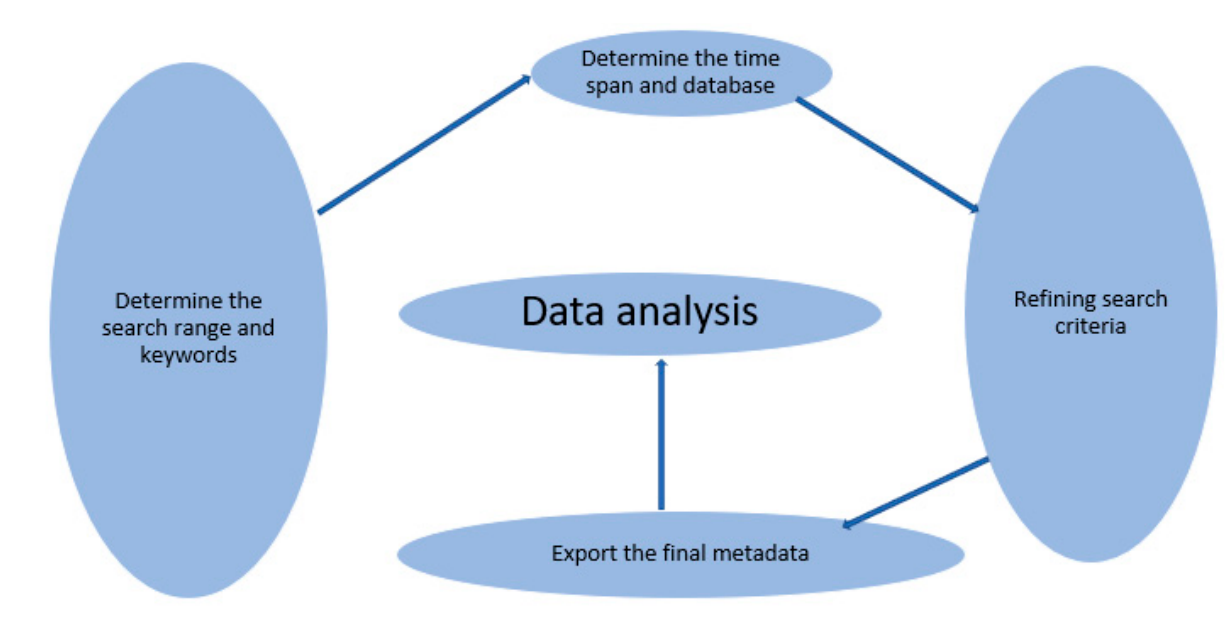
Figure 1. The methodological phase of bibliometric analysis. Table 1. Types of retrieved documents on remdesivir research publications (2016–2021).